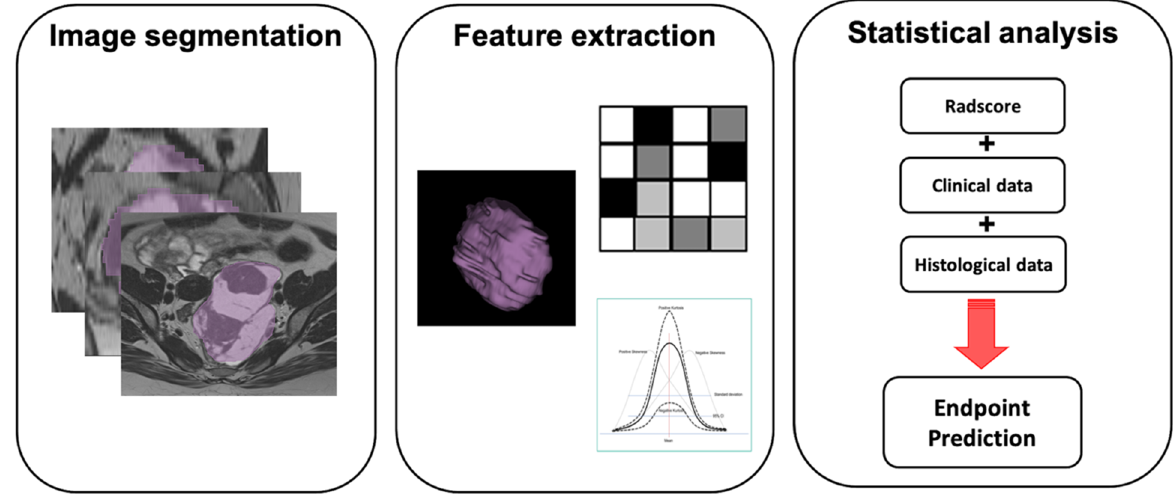
Figure 1. Ovarian cancer radiomic workflow. Image segmentation: ovarian cancer manually segmented on axial CT slice; feature extraction: tumor shape, texture and integration data; statistical analysis: combination of radiomic features with clinical and histological data to obtain predictive model.